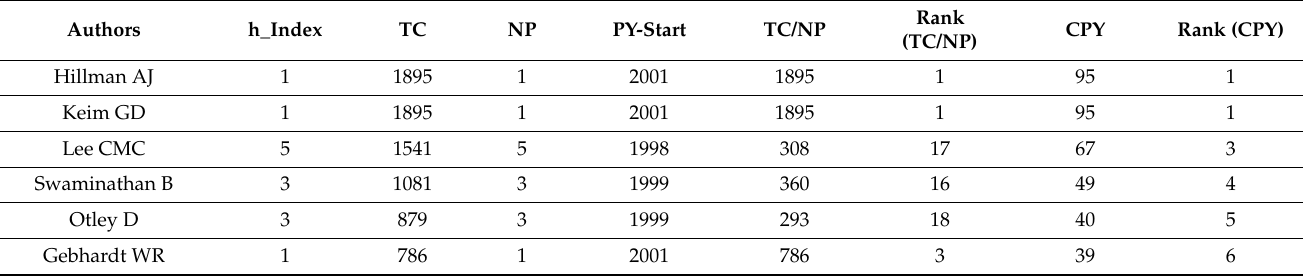
Table 2. Leading Performing Authors in the EVA Research